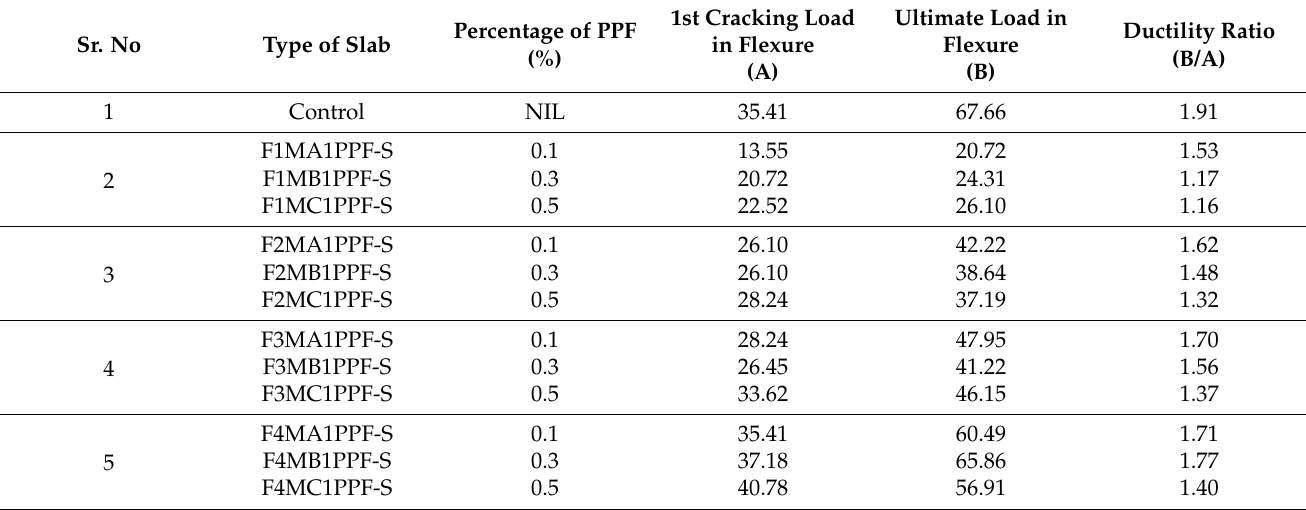
Table 6. Ductility ratio of ferrocement and controlled